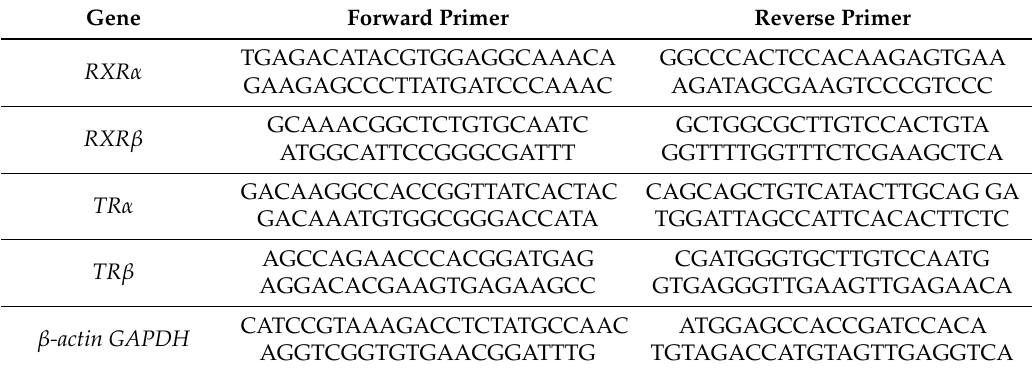
Table 1. Primer sequences for real-time